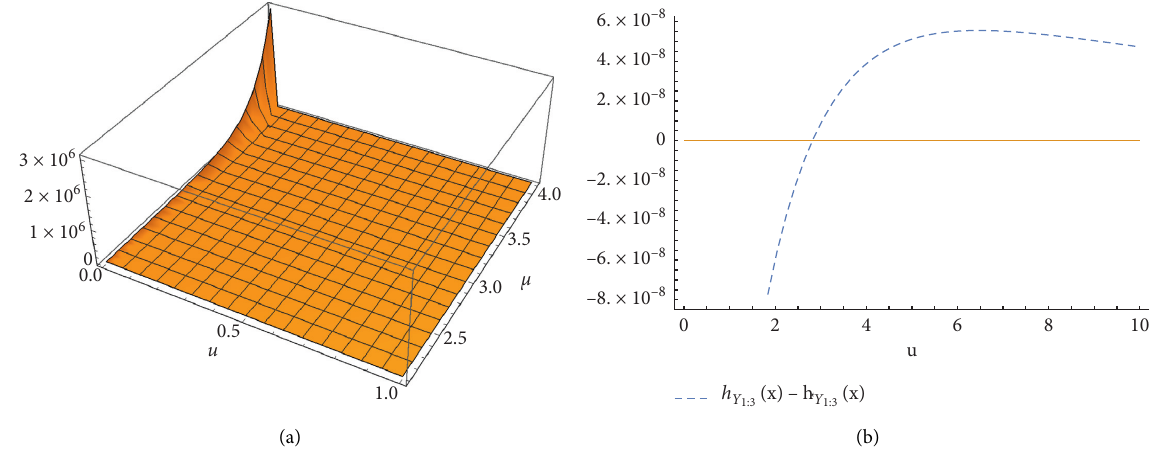
Figure 5: Plot of the difference function h